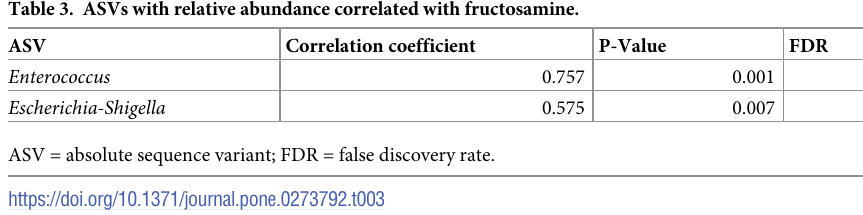
PLOS ONE | https://doi.org/10.1371/journal.pone.0273792 September 6,